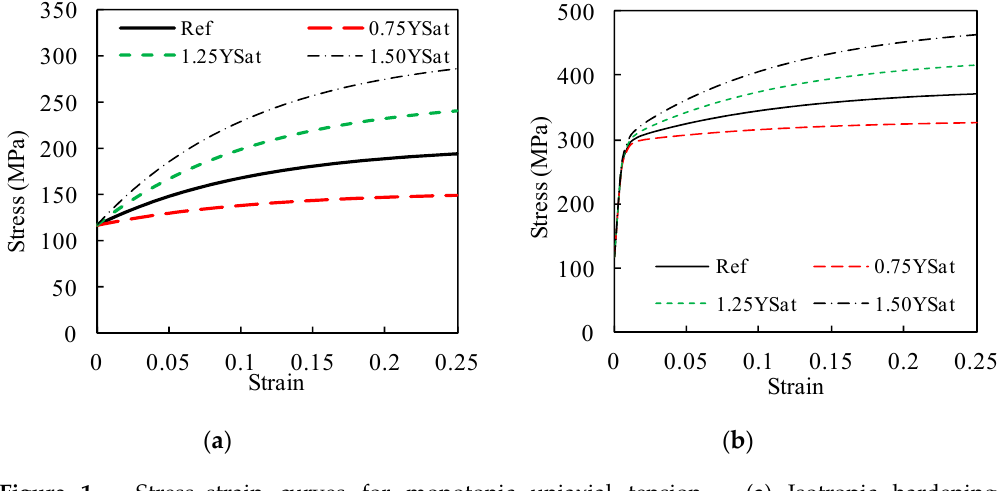
Figure 1. Stress–strain curves for monotonic uniaxial tension. ( a ) Isotropic hardening. ( b ) Mixed hardening.